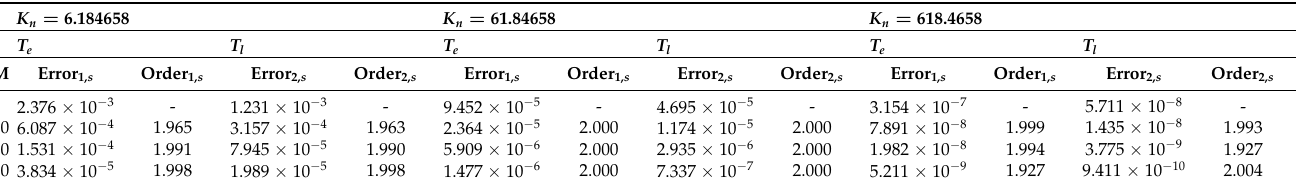
Table 9. Spatial convergence rate when N = 50,000 and ( α , β ) = ( 0.2,0.9 ) for Example